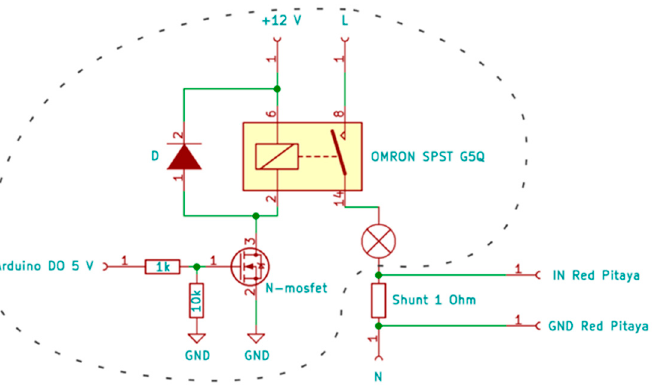
10 of 18 Figure 14. Tunnel lid with positioned sensors: ( a ) The outer side where the PCB with the sensors is placed; ( b ) The inner side, which shows the 20 mm diameter aperture. 2.10. Electric Circuit for Measuring the Electric Current through a Light Bulb The measured current is the AC current of the mains voltage. The measurement of the electric current through the light bulb is performed using a shunt resistor connected in series with the light bulb as seen in the figure 15. The voltage drop across the shunt resistor is measured with respect to time. The data acquisition is performed using a Red Pitaya measurement device with a sampling frequency of 300 kHz. Figure 15. Electric circuit diagram for measuring the electric current through a light bulb (circled area). The measuring system was used to perform measurements on 59 LED light bulbs. Due to the large number of selected light bulbs, we wanted to automate the measurements